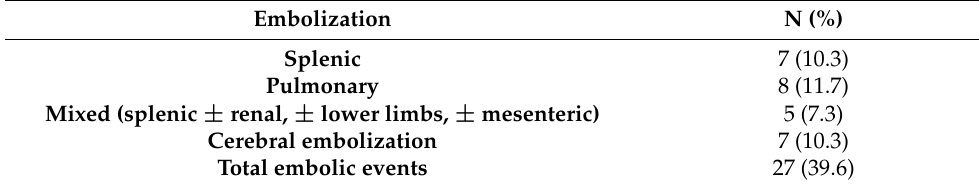
Figure 1. Population of 68 patients with infective endocarditis divided by aetiologic agent. CoNS: coagulase- negative staphylococci; HACEK: stands for Haemophilus species, Aggregatibacter species, Cardiobacterium hominis , Eikenella corrodens , and Kingella species; BCNIE: blood-culture-negative infective endocarditis. Table 3. Embolic complication in 68 patients with infective endocarditis.